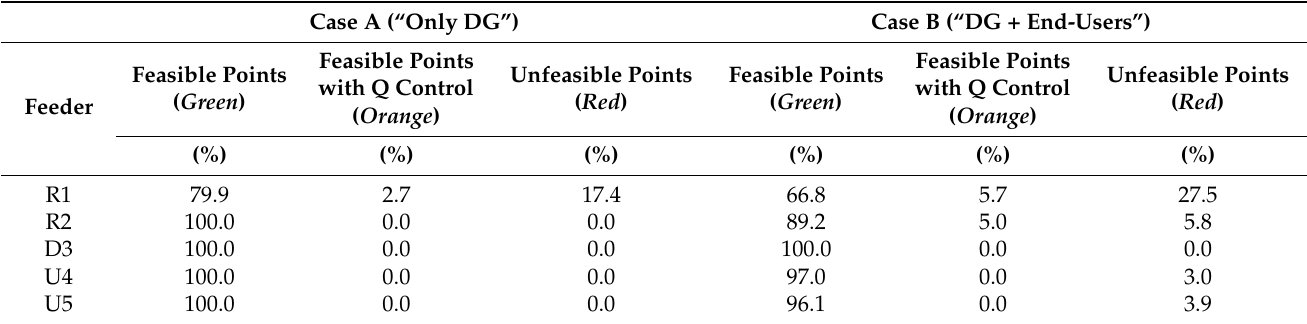
Table 3. Operating point occurrences differentiated for each feeder in the Case